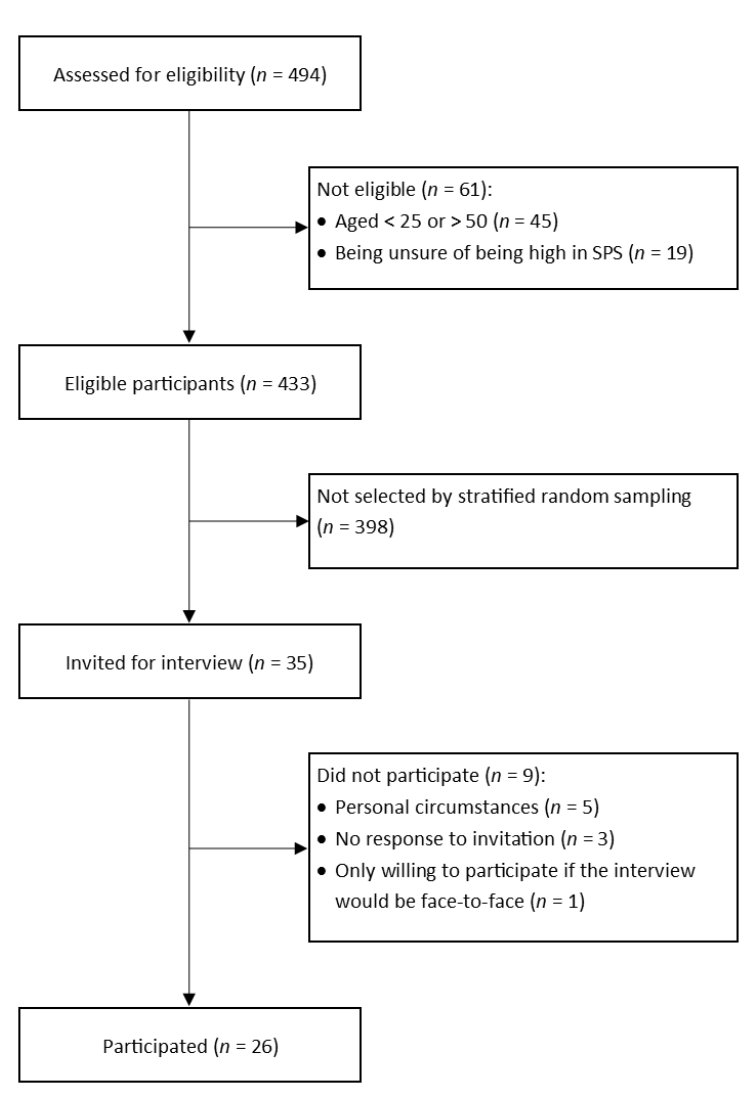
Figure 1. Flowchart of participant recruitment.